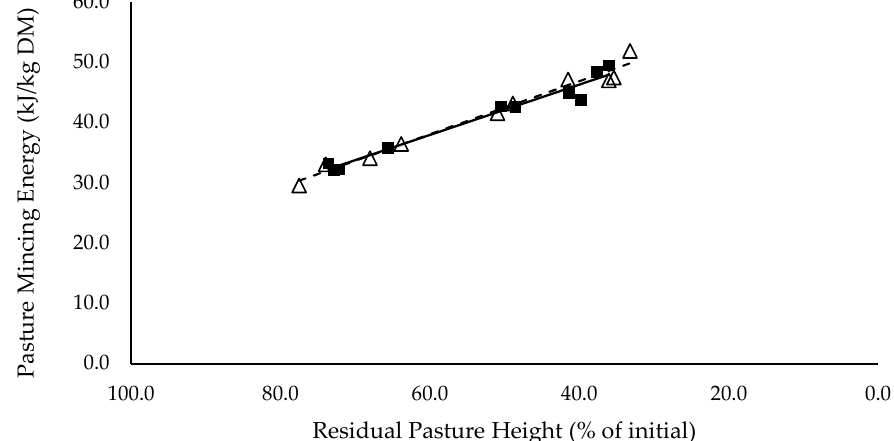
Figure 3. The relationship between average pasture mincing energy (kJ / kg DM) and residual pasture height (% of initial) for high ( ■ ) and low (Δ) mixed ration levels. Lines were fitted for high (solid) and low (dashed) mixed ration levels.